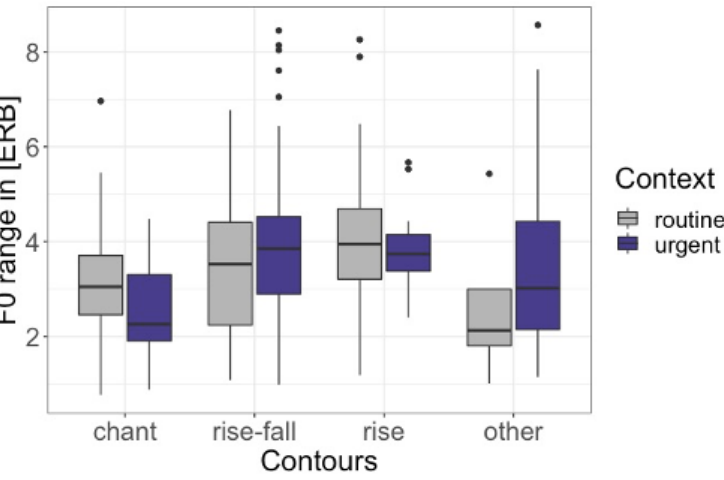
Figure 12. F0 range in the routine and urgent context across different calling melodies in